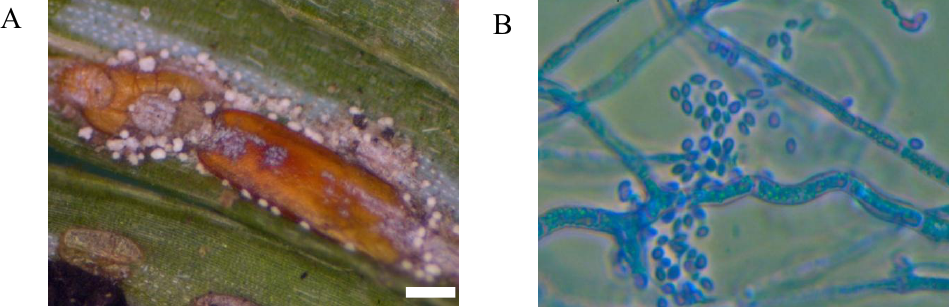
Figure 4. Elongate hemlock scale mycosis caused by the fungus Metarhiziopsis microspora : scales with sporodochia ( A ); mature conidia, cotton blue stain, objective ×100 ( B ). (Bar = 0.5 mm)